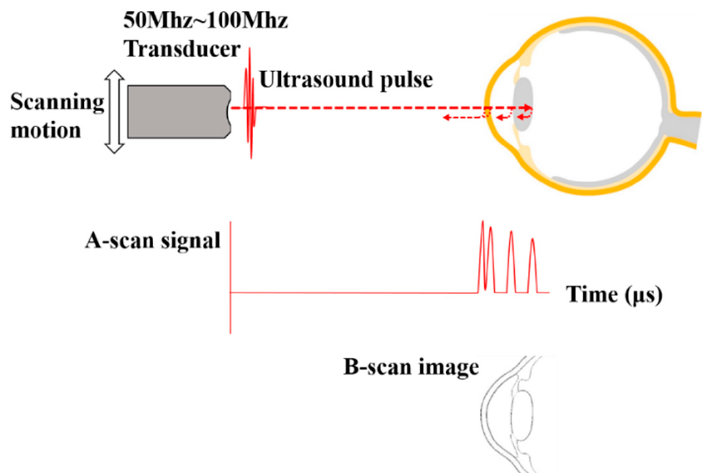
Figure 14. The basic principle of ultrasound biomicroscopy (UBM). The transducer generates an ultrasound pulse. The pulse encounters the anterior segment tissues. The backscattered echoes would be detected by the same transducer, resulting in the A-scan signal to indicate the distances between the tissues. The B-scan image of the anterior segment could be obtained by scanning.